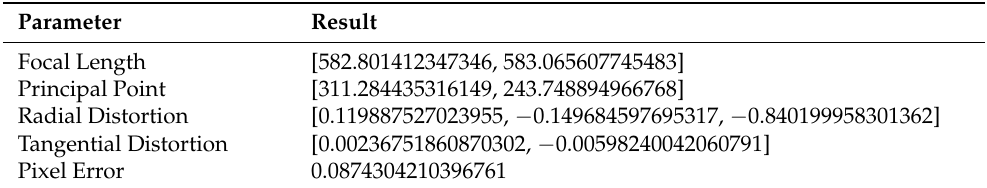
Table 1. Internal parameters of the